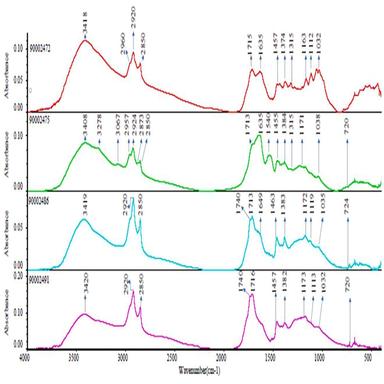
FT-IR spectra of samples 90002472, 90002475, 90002486 and 90002491.